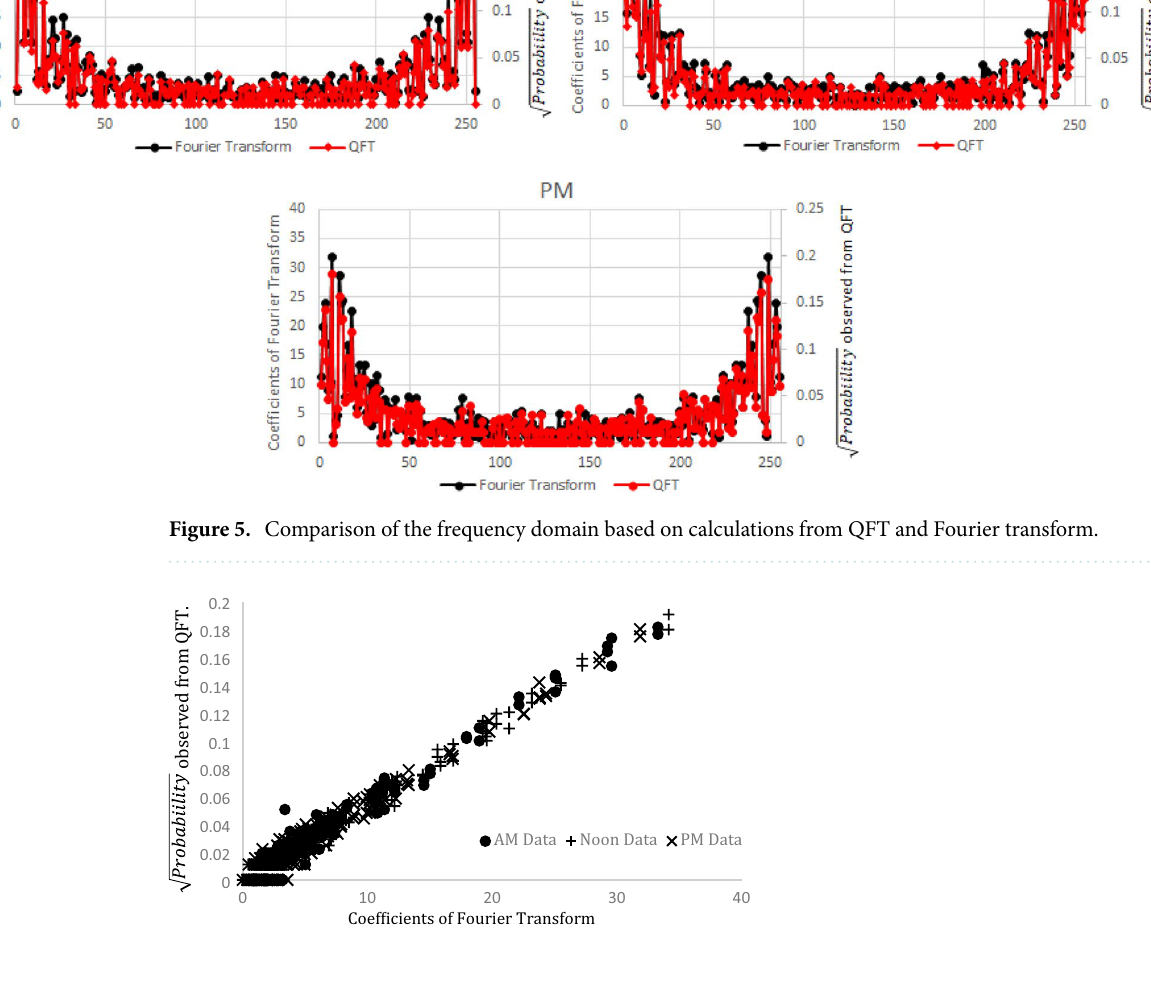
Figure 6. Comparison of the coefficients of the Fourier transform and